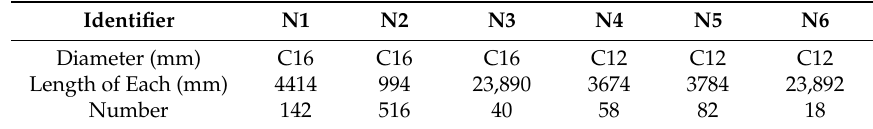
Figure 2. Details of reinforcement bars. Table 1. Mechanical properties of reinforcement steel.